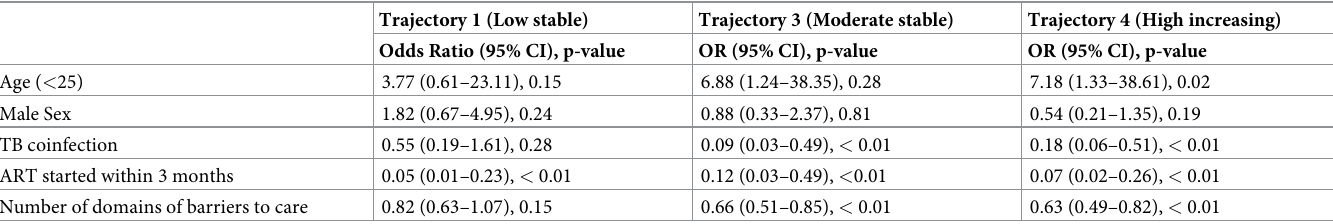
Table 2. Predictors of trajectory assignment (reference group trajectory 2, low